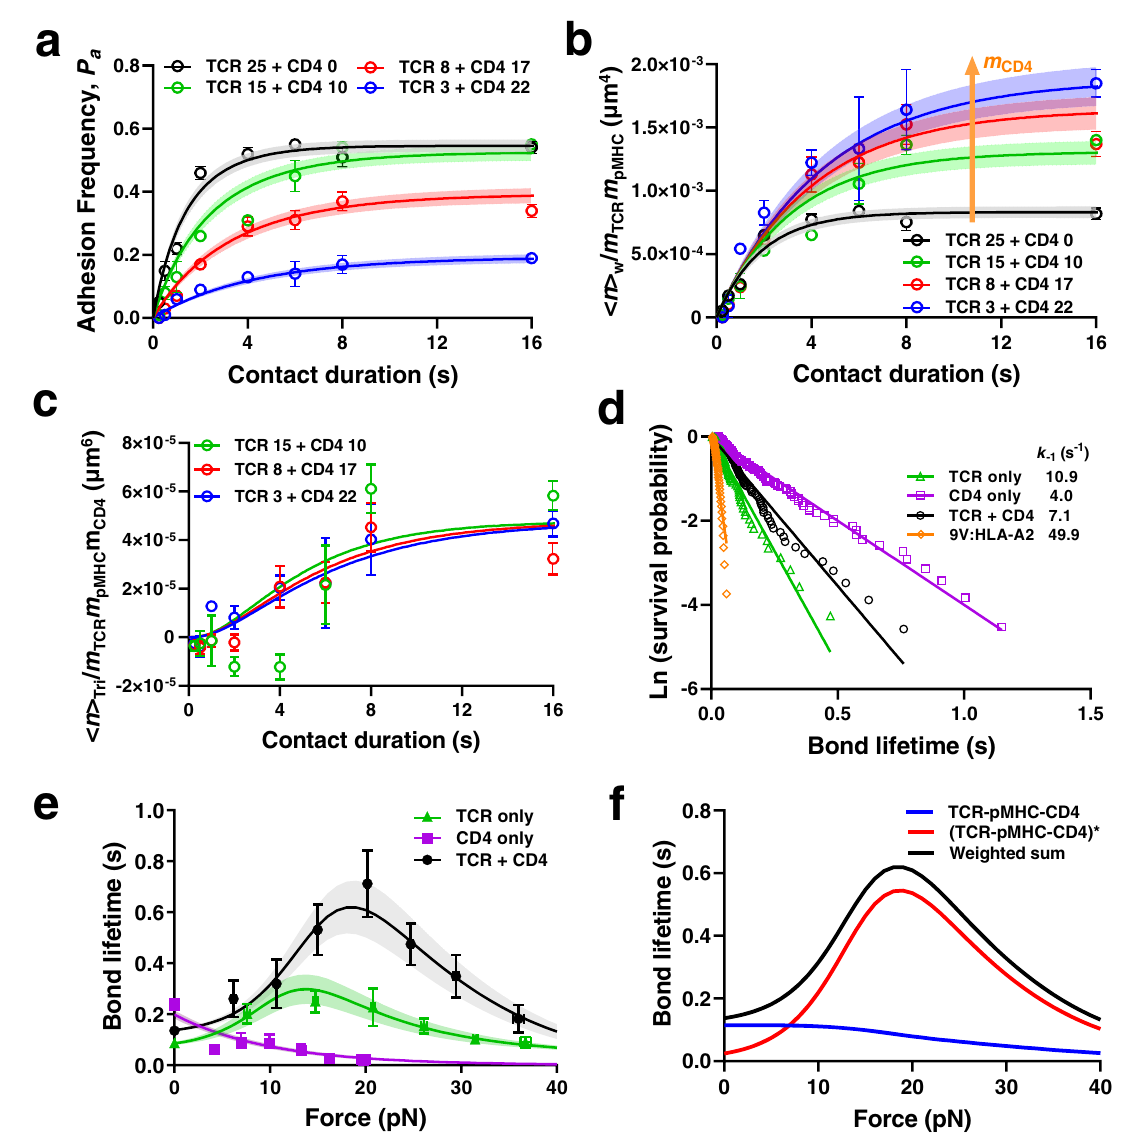
Fig.2|EctodomainsofTCRandCD4bindcooperativelytopMHC.a P a vs t c data (points, presented as Mean ± SEM) and their model fi ts (curves) of pMHC-coated RBCs (38 μ m − 2 ) binding to RBCs coated with TCR alone, or a mixture of TCR and CD4 at densities (# of molecules/ μ m 2 ) indicated by the numbers in legend. b Normalized whole bond number < n > w / m TCR m pMHC vs t c data (points, presented asMean±SEM)andtheirrespectivemodel fi ts(curves)forinteractionsin a .Arrow indicates decreasing density of TCR and increasing density of CD4. c Normalized trimolecular bond number < n > tri / m TCR m pMHC m CD4 vs t c data (points, presented as Mean ± SEM) and their respective model fi ts (curves) calculated from b by sub- tracting the black data from colored data followed by further normalization by m CD4 . d Survivalprobabilitiesplotted asln(# of eventswithlifetime greaterthan t ) vs. bond lifetime for pMHC-coated beads interacting with beads coated with TCR, CD4,ora1:1mixtureofTCRandCD4measuredbyBFPthermal fl uctuationatzero